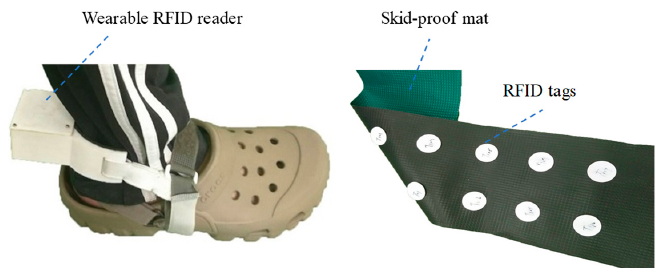
Figure 4. Photograph of the indoor walking distance measurement device.